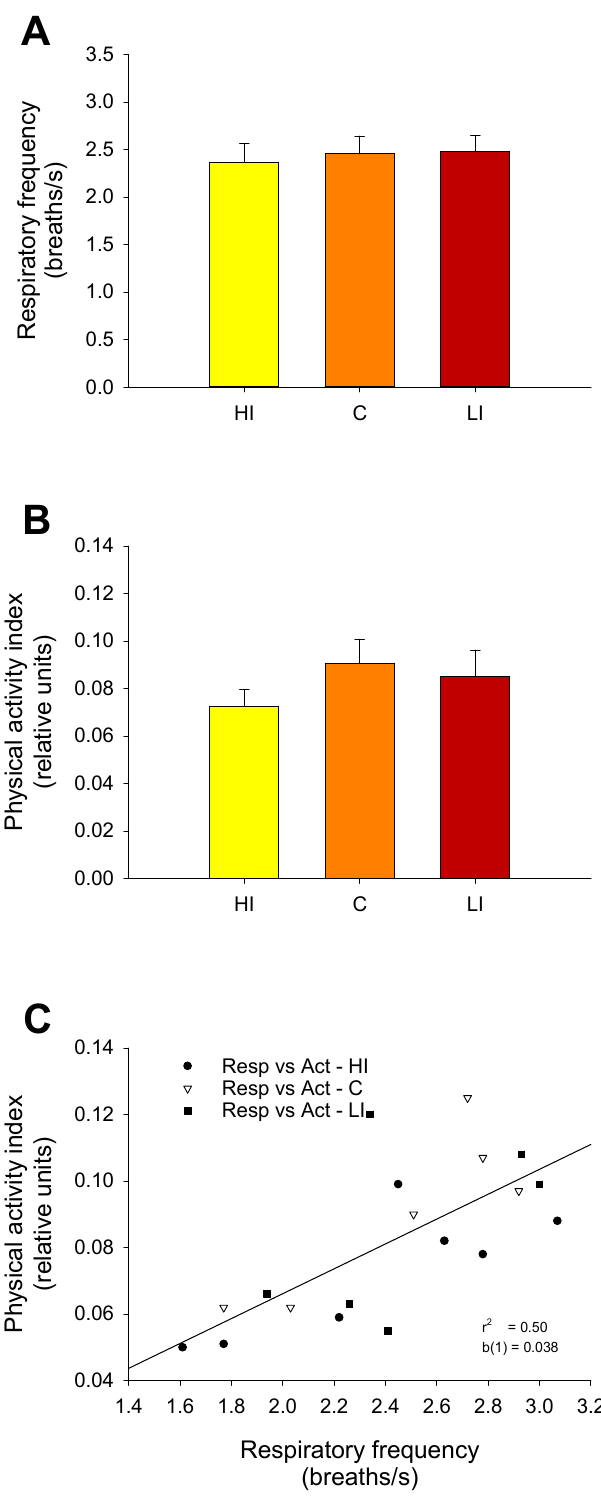
Figure 4. Daily averaged AEFishBIT records of respiratory frequency ( A ) and physical activity ( B ) after three days of exposure (D1–D3) to different light intensities: HI (yellow bars), C (orange bars), and LI (red bars). Each value is the mean ± SEM of 6–7 individuals. ( C ) Linear correlation between respiratory frequency and physical activity of fish individuals exposed to HI (circles), C (triangles), or LI (squares) lighting.